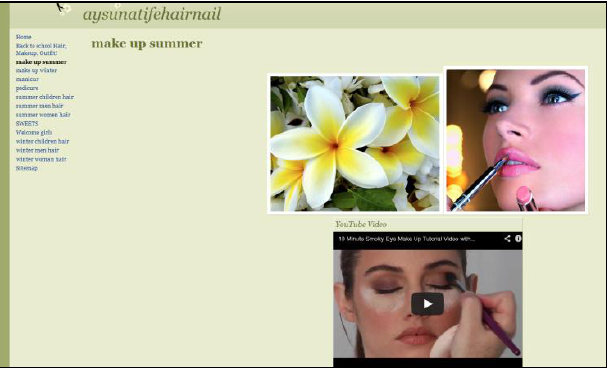
Figure XII. Citizenship